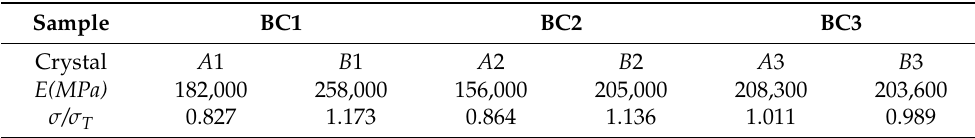
Table 4. Elastic moduli and the ratio of the applied stresses on the component crystals to the total